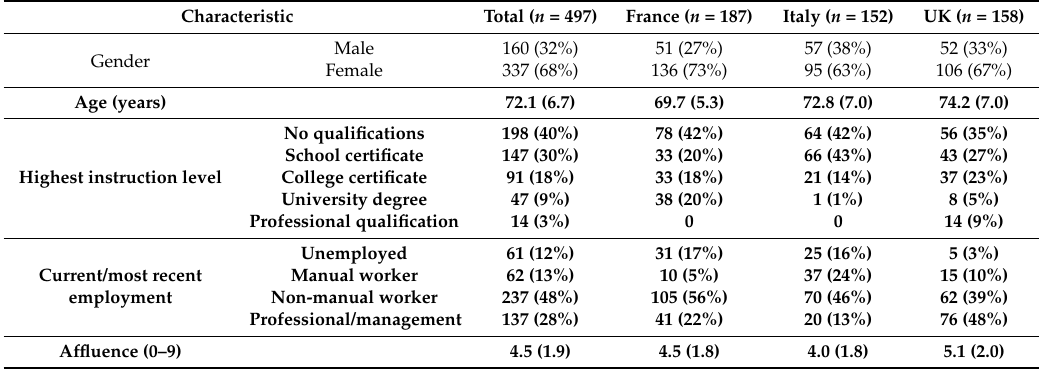
Table 1. Descriptive statistics ( n and %, or mean and standard deviation) for demographic variables in all three countries ( n = 497).